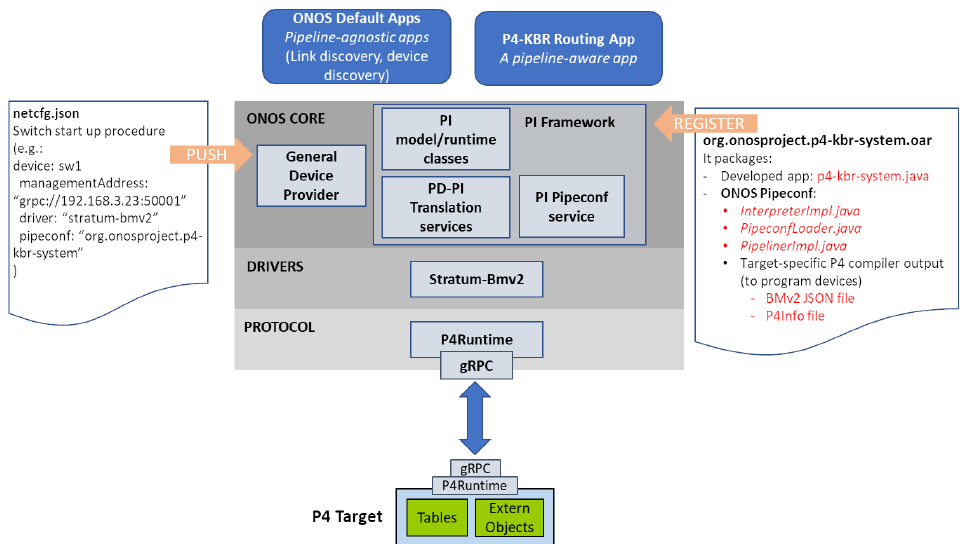
Figure 7. ONOS and P4. Pipeline Independent (PI) framework allows the ONOS to manage and deploy a pipeline-aware